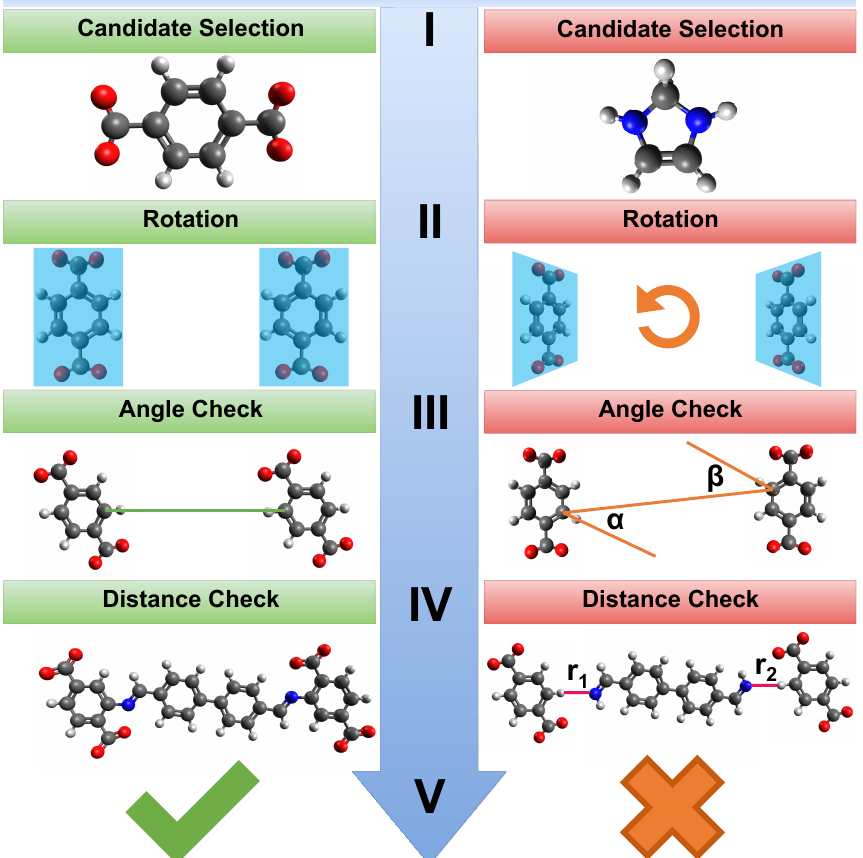
Figure 2. Flowchart of the screening process: (left) Ideal case of a MOF (right) structures that do not fulfill the selection criteria. In the preprocessing the parameters for the cross-linker and filters are set as input values. The first step (I) looks for all candidates. In our case these are hydrogen atoms from an aromatic ring. The second step (II) checks if a rotation is necessary. If so, the candidates are rotated towards each other. The next step (III) calculates the angles α and β that define the line of sight from one candidate to another (or to the geometric center). If these angles are above the angle limit, the structure is dismissed. The last filter (IV) checks if the cross-linker length fits between two (or more) candidates. Here, this is not the case on the right hand side where r 1 and r 2 represent too large bond lengths. The MOF is saved if all filters are passed (left) or dismissed otherwise (right)